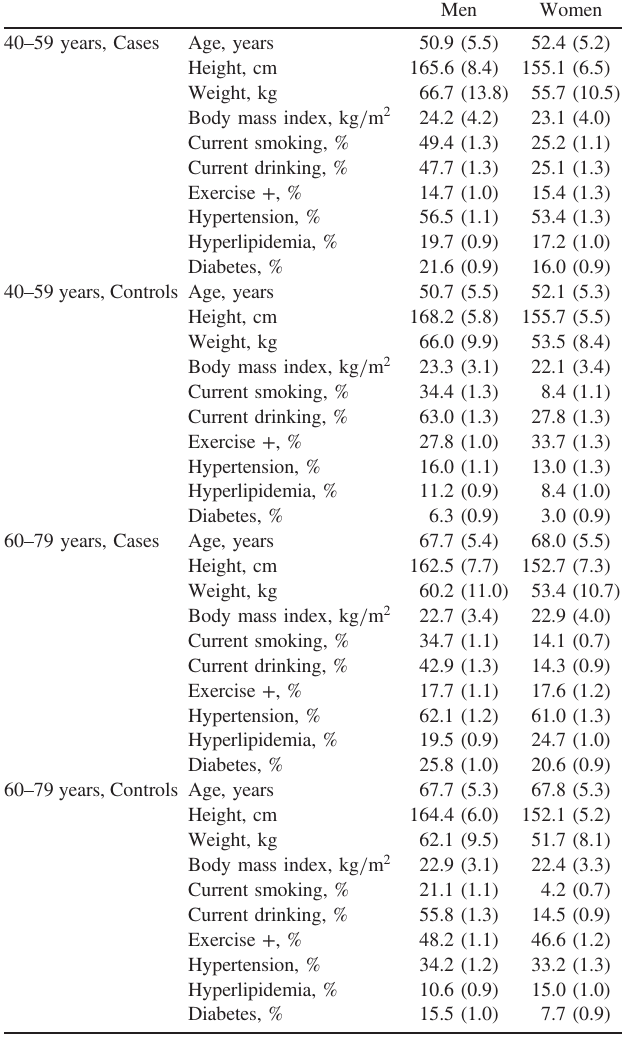
Table 2. Potential confounding factors for stroke in total stroke cases and